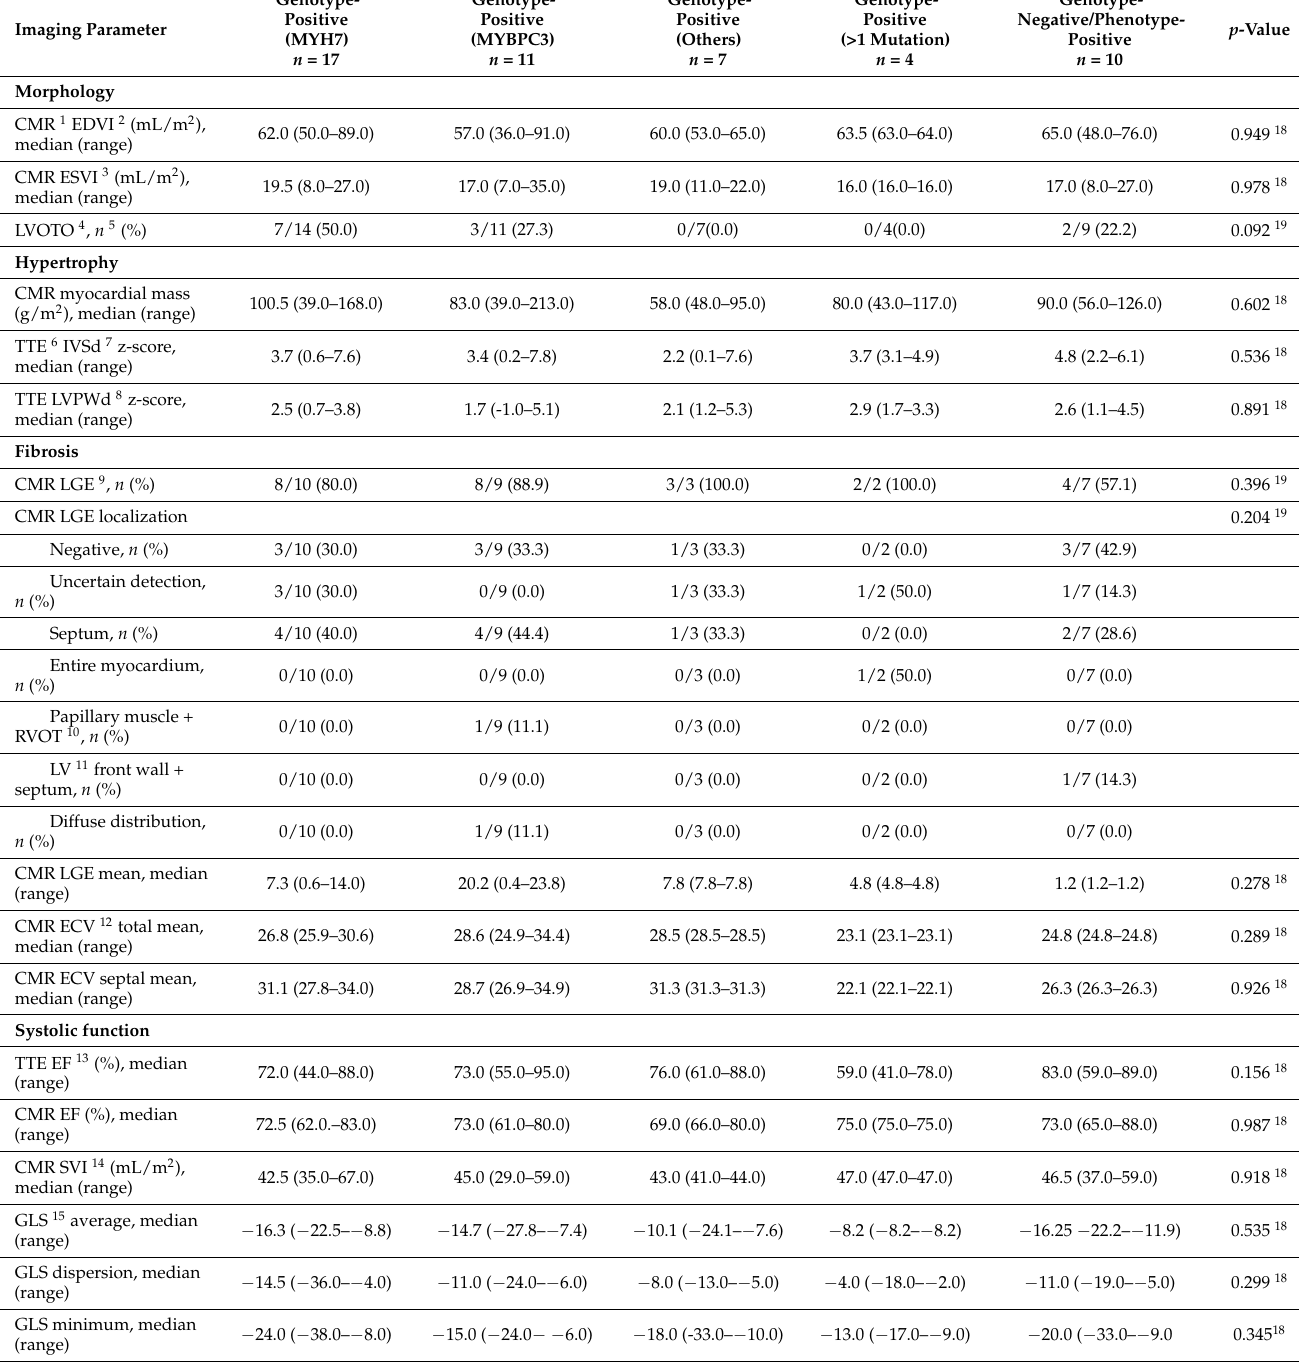
Table 2. Disease phenotype at latest